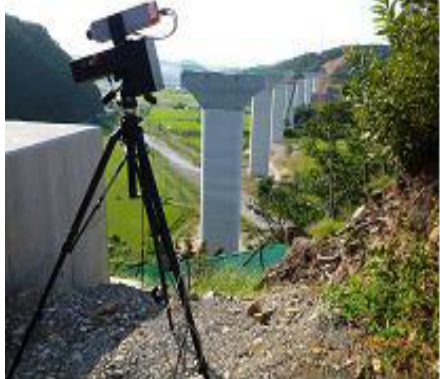
Figure 11. Photography using VNIR camera on Daejongchun Bridge